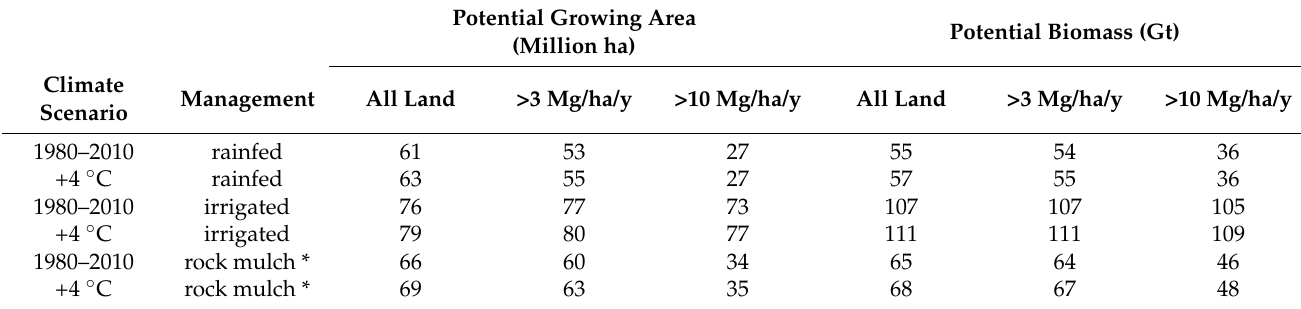
Table 1. Summary of potential area (10 6 ha) and potential biomass (10 9 Mg) of Agave americana with different scenarios for climate and management.